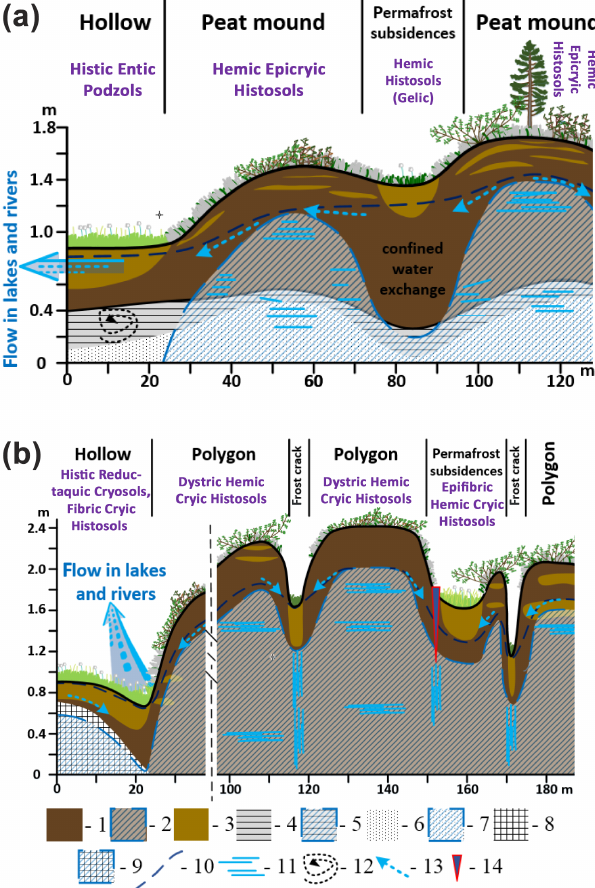
Figure 2. Soil transect of typical bog micro-landscapes of flat mound palsa (a) and polygonal frozen bog (b) . This vertical line in panel (b) indicates a discontinuity of hydrological flow path. The numbers on the legend represent the following: 1, moss–lichen– sedge peat of medium degree of decomposition (Hemic); 2, perma- nently frozen peat; 3, moss-based peat of low degree of decomposi- tion; 4, illuvial–Fe–humic (spodic) horizon; 5, permanently frozen spodic horizon; 6, sand and silt deposits; 7, frozen sand and silts; 8, heavy clay deposits; 9, frozen clays; 10, the level of supraper- mafrost waters in August; 11, ice wedges; 12, cryoturbation features in soil; 13, the direction of soil water transport, typically along the permafrost boundary; 14, small crack on the polygonal